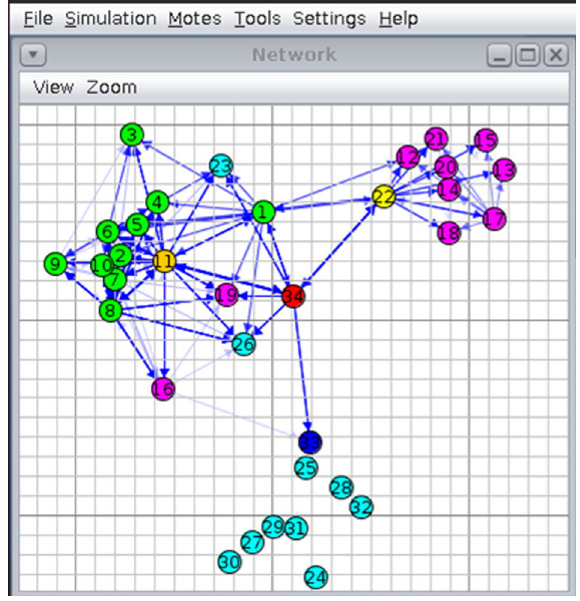
Fig. 12 Modified random smart home with